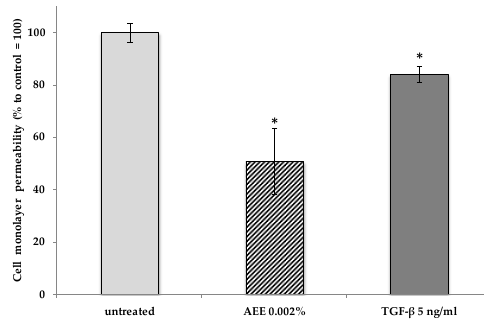
Figure 4. Intercellular permeability assay. HDLEC were previously treated with the AEE and TGF-β (positive control) and then exposed to the fluorescent compound fluorescein. The amount of fluorescein passed through the cell monolayer was measured by a spectrophotometer. All determinations were conducted in triplicate and the results are expressed as mean ± SD. * p < 0.05 compared to the untreated control.